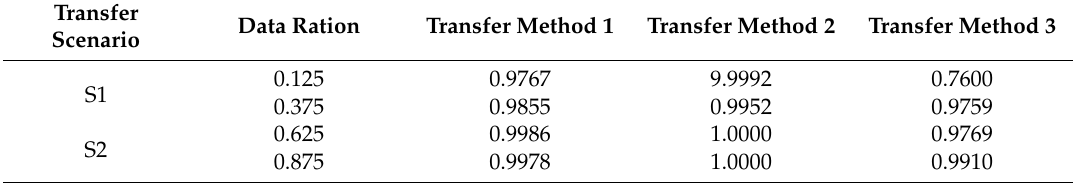
Table 5. Summary of Correctness Rate of Transfer Test under Di ff erent